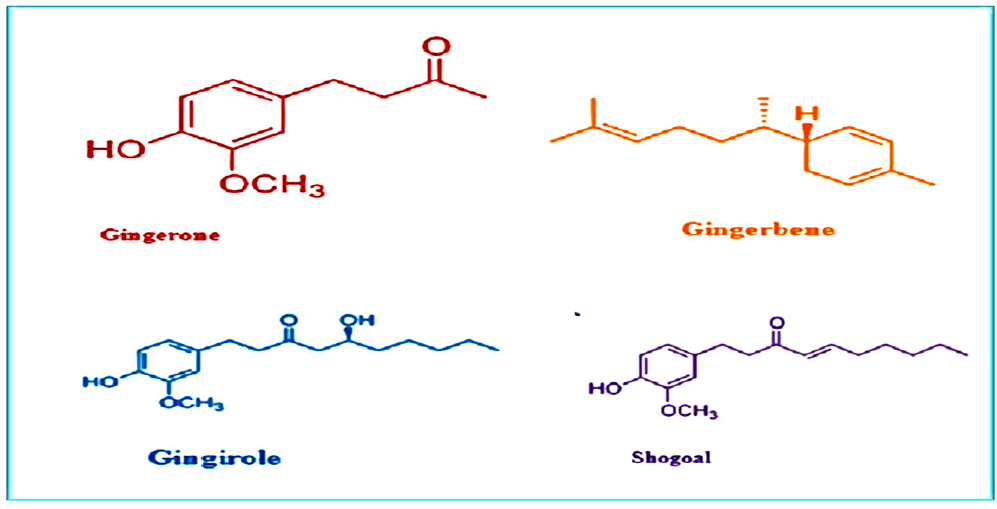
Figure 3. Chemical structure of important phytochemicals present in ginger.